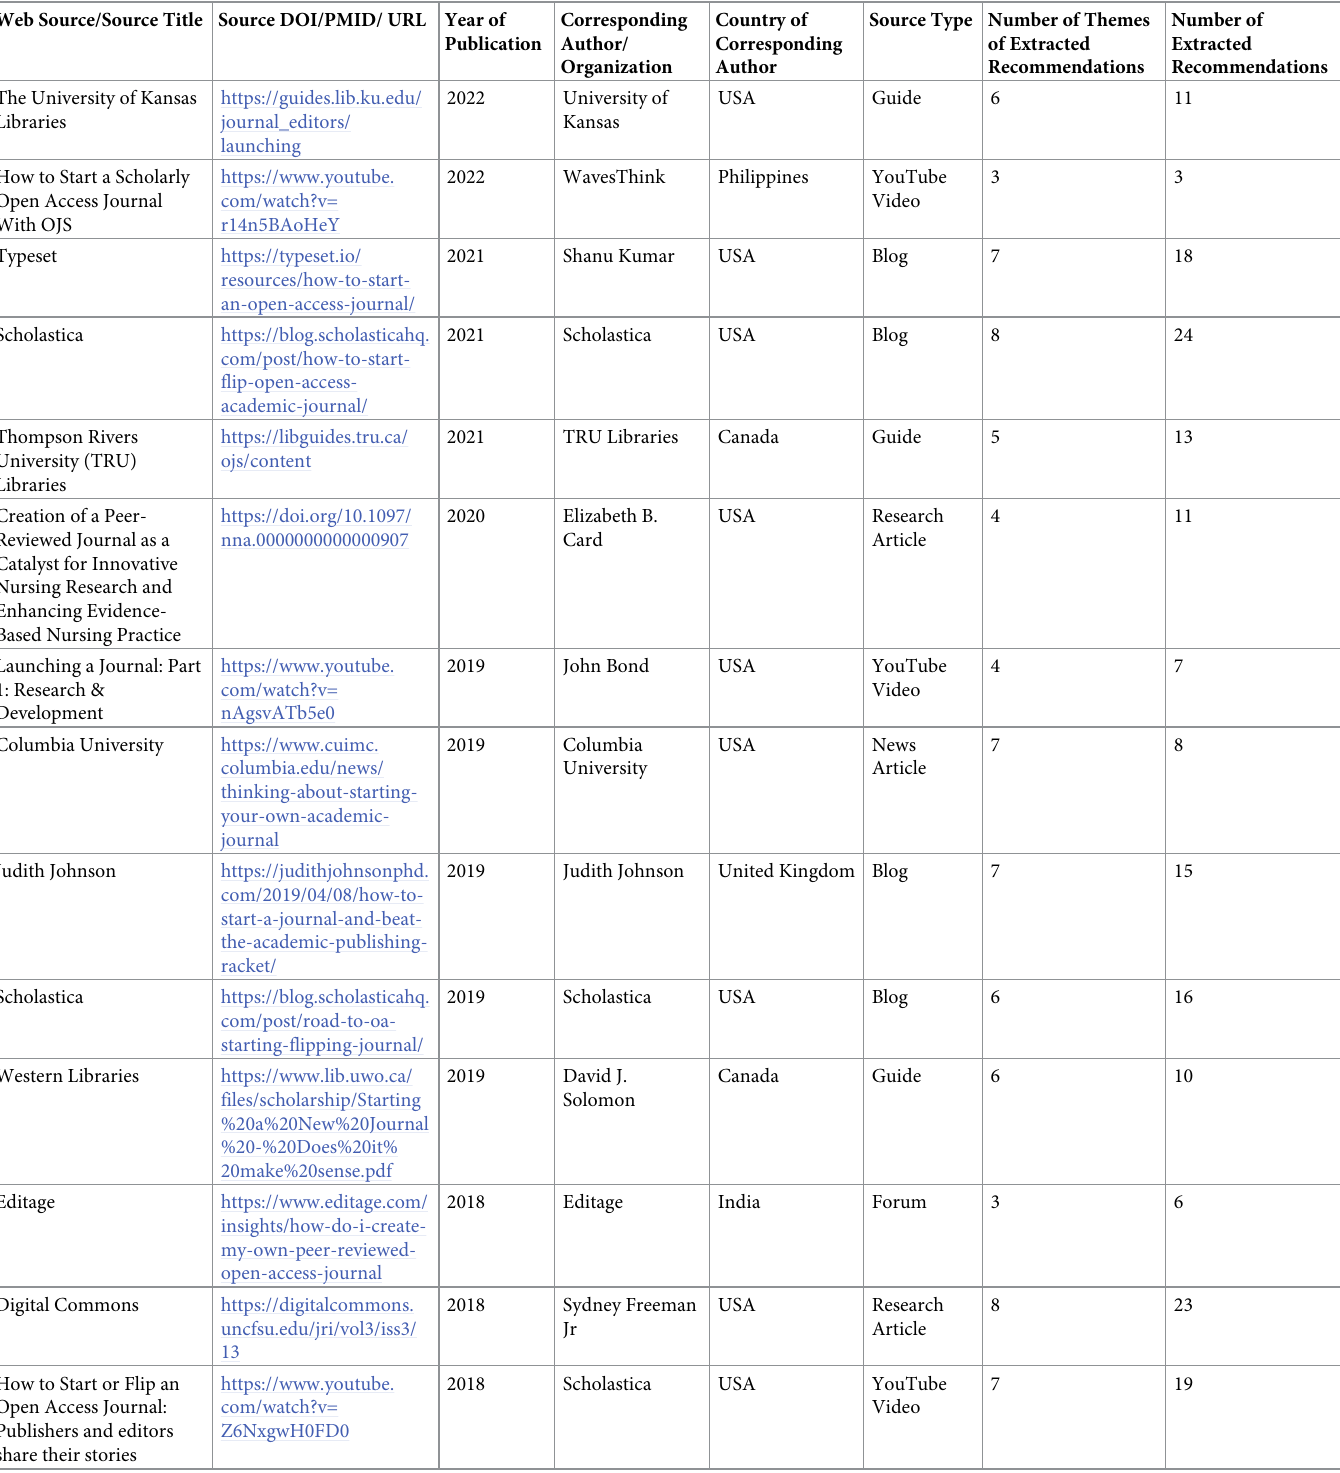
Table 5. General characteristics of included evidence-based sources (n =